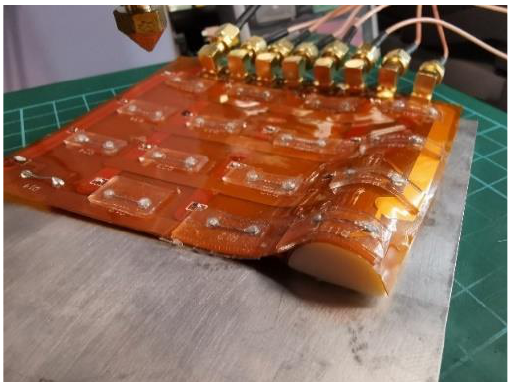
Figure 14. Flexible sensor mounted onto bending surface with thumb-like size.